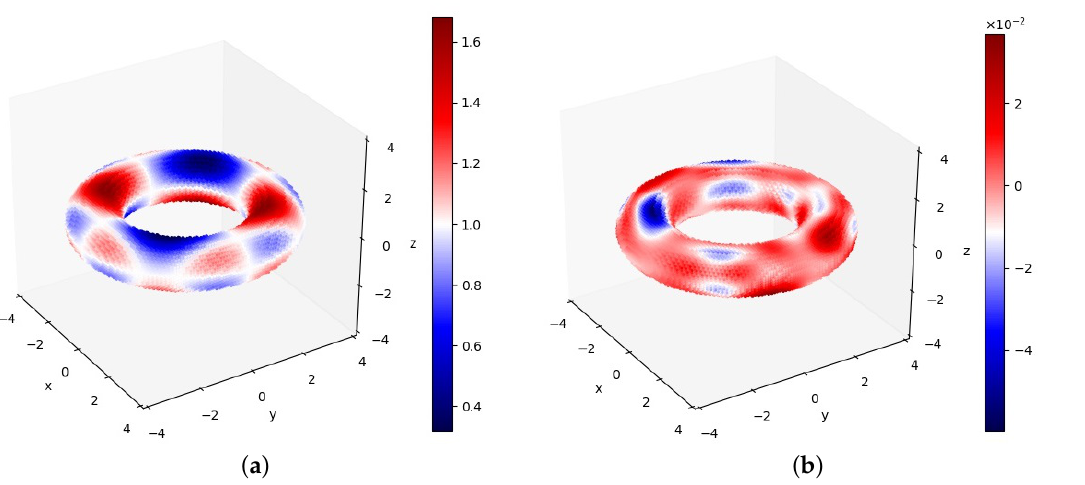
Figure 21. ( a ) The PINN solution and ( b ) the error between PINN and the exact solution on exter- nal